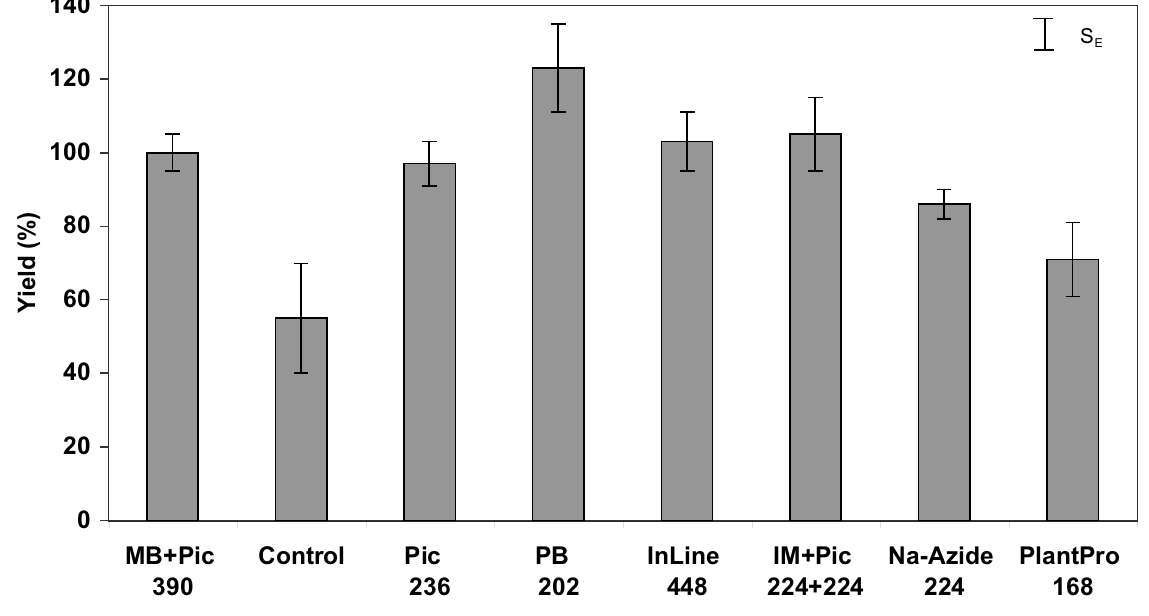
Fig. 2. Total strawberry yields from drip fumigation with alternative fumigants relative to standard MB + Pic (390 kg ha -1 ) (87.9 t ha -1 ) fumigation. Values are averages of data collected from two regions in California, USA, over a 2- year study period with the exception of sodium azide and PlantPro which are averages of data collected over a 1- year. Abbreviations: MB, methyl bromide; Pic, chloropicrin; PB, propargyl bromide; IM, iodomethane; Na-Azide, sodium azide; S , standard E